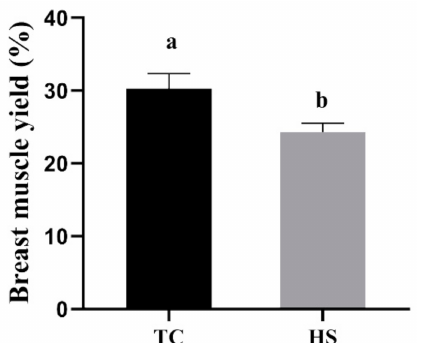
Figure 2. Effects of heat stress on the breast muscle yield of broilers. TC, thermoneutral control group; HS, heat stress group. Each bar presents the means ± SD ( n = 6). a,b Values with different superscripts differ significantly at p <